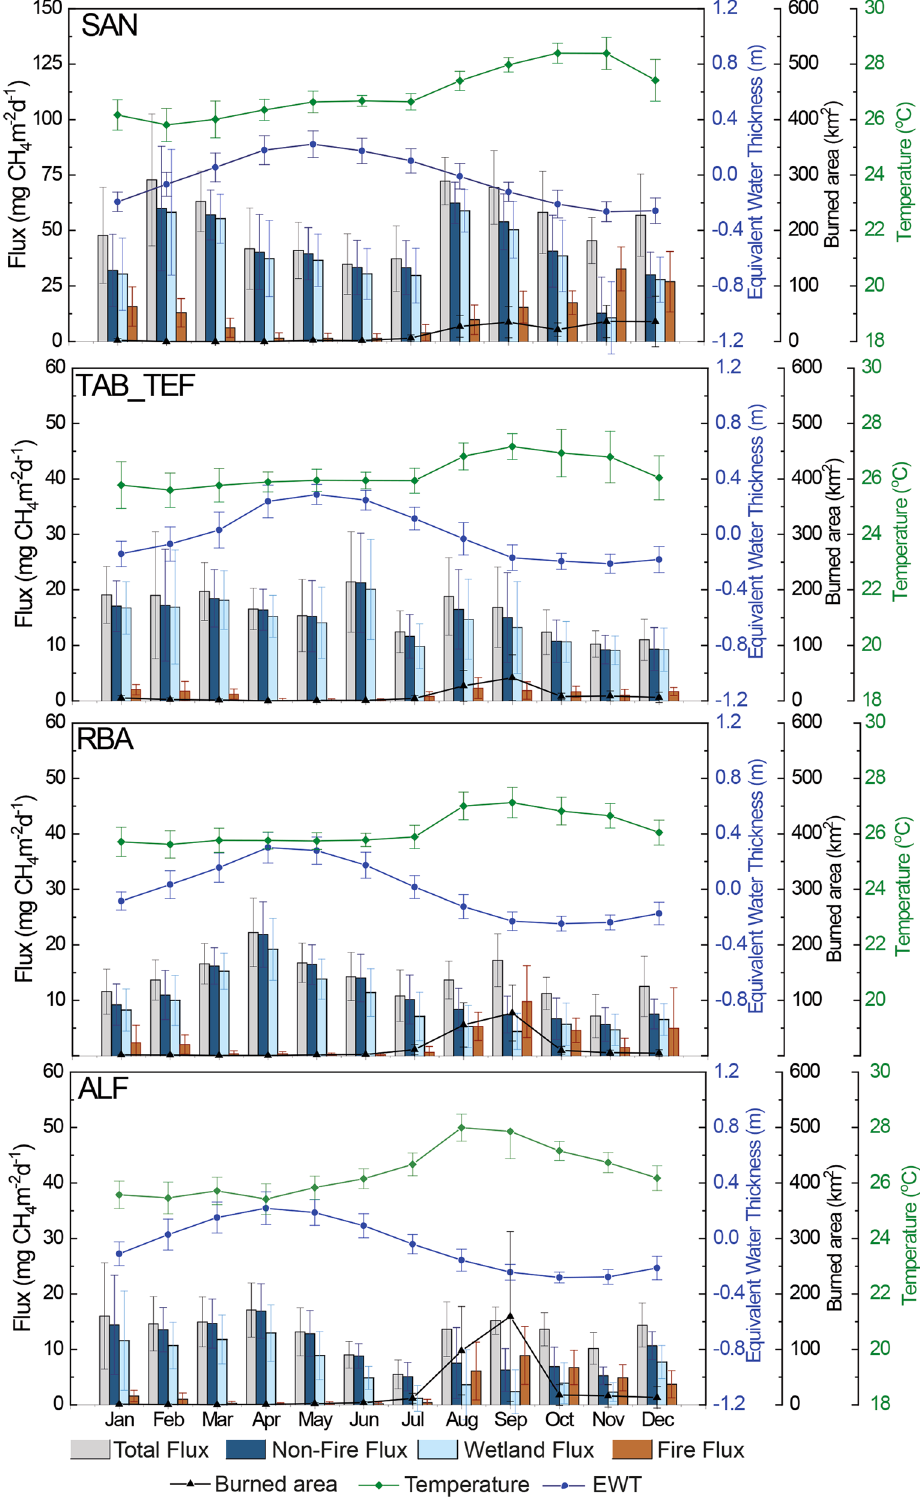
Fig. 3 Climatological (2010 – 2018) monthly mean CH 4 fl uxes estimated using vertical pro fi les. CH 4 fl ux monthly means for total (grey bars), non- fi re (total less fi re emissions; dark blue bars), wetlands (non- fi re less anthropogenic and termite emissions, plus the CH 4 uptake from upland soils; light blue bars) and fi re (brown bars), air temperature (green lines), equivalent water thickness (EWT; blue lines) and burned area (black lines) for all regions. Error bars represent the standard deviation of monthly means over the nine years. Note the expanded fl ux axis for